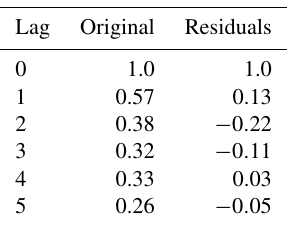
Table A3. Correlations between (second column) time-lagged repli- cates of the original C i and (third column) time-lagged replicates of the residuals of the four-segment